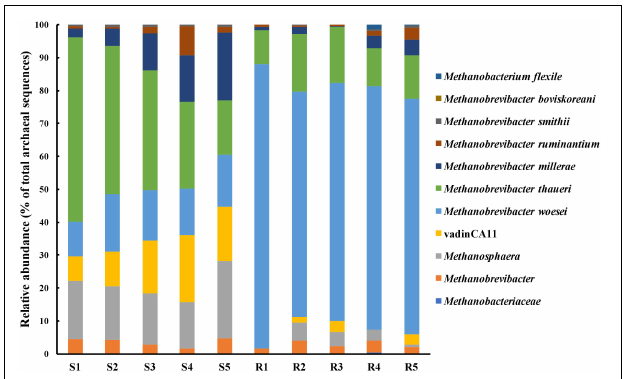
FIGURE 4 | Comparison of the relative abundance of species and genera of methanogens identified in the two digestive organs. S1–S5, the five sheep; R1–R5, the five blocks of